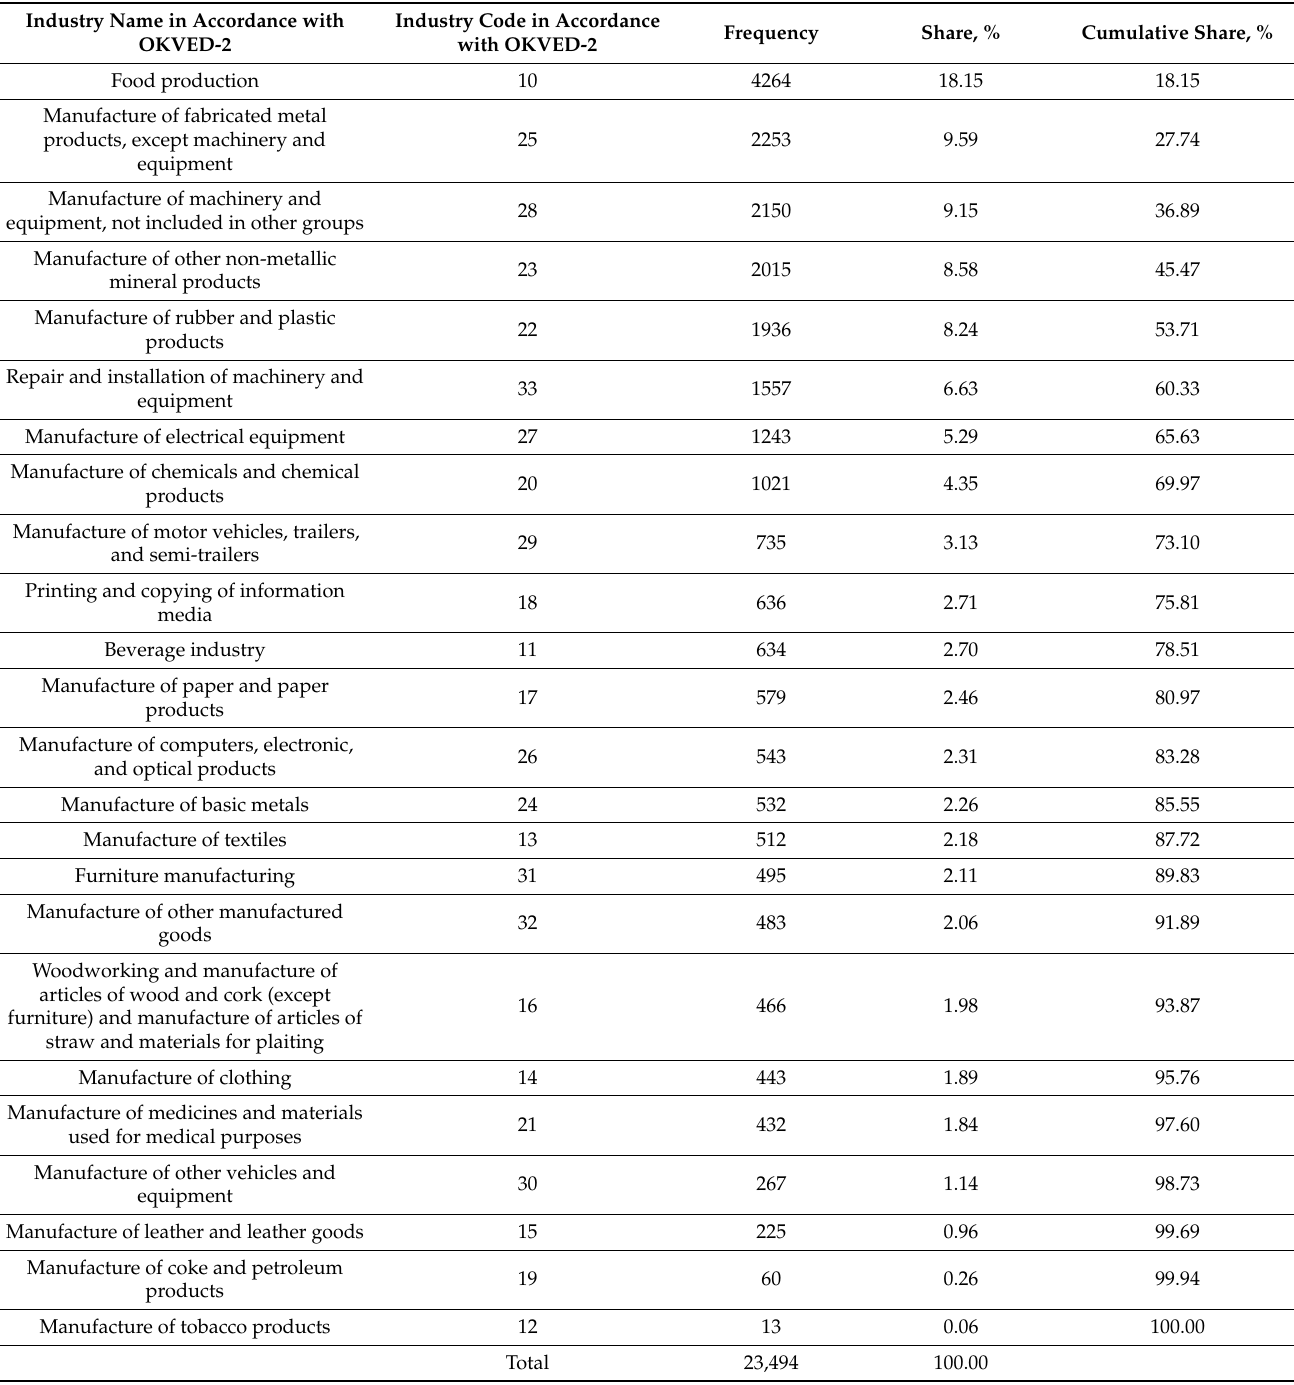
Table A3. Frequency distribution of selected observations across